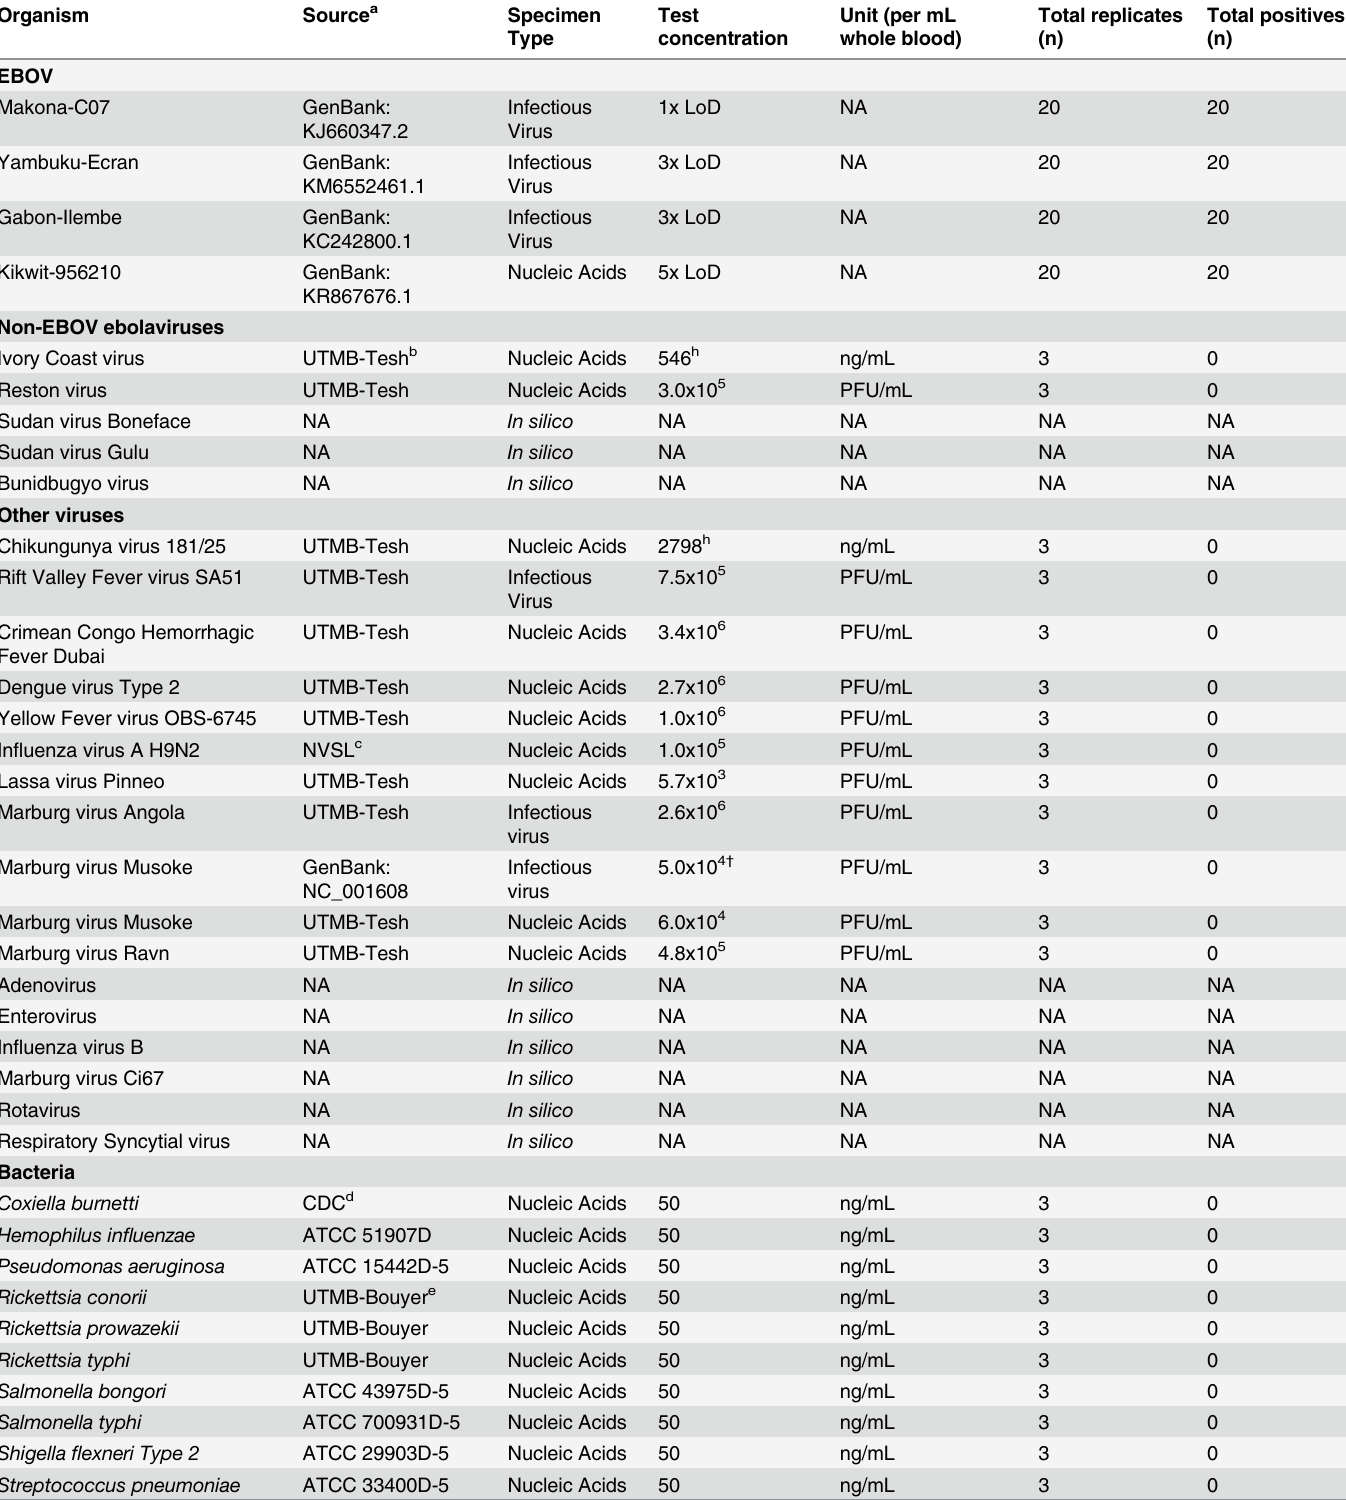
Table 5. Analytical Reactivity and Specificity (Inclusivity and